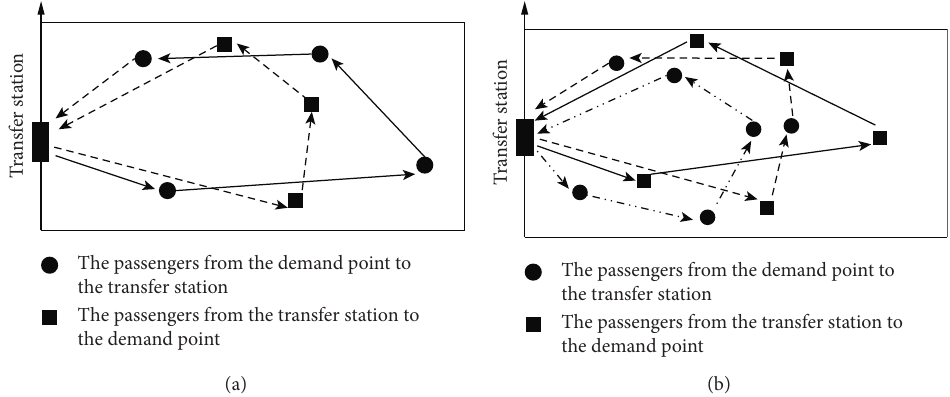
Figure 2: The vehicle route of different operation modes. (a) Alone running mode (only pick-up or deliver). (b) Mixed running mode (both pick-up and